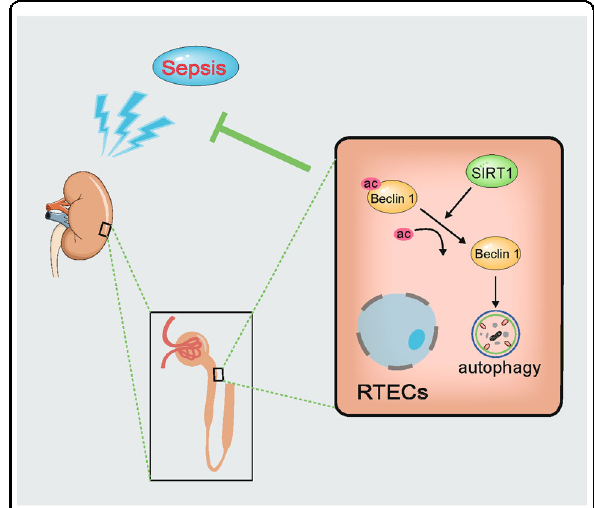
Fig. 8 The effect of SIRT1-mediated Beclin1deacetylation induces autophagy in attenuating sepsis-induced acute kidney injury (SAKI). RTECs renal tubular epithelial cells, Ac